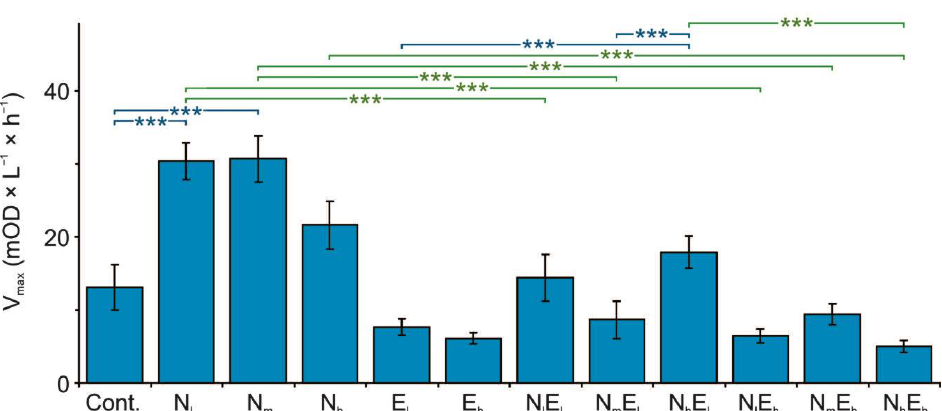
Figure 3. Mean values (±1 SE) of respiration rate expressed as V max values of 31 carbon sources by Daphnia gut microbiota from the control variant (Cont.) and from variants of a single or combined low, medium, and high density of polystyrene NPs (N l = 10 3 , N m = 10 6 , and N h = 10 9 particles L − 1 , respectively) and low and high concentration of enrofloxacin (E l = 10 and E h = 100 ng L − 1 , respectively). Statistical significance is accepted at *** p < 0.0005. The NPs effect is marked on blue, and the enrofloxacin effect on green.